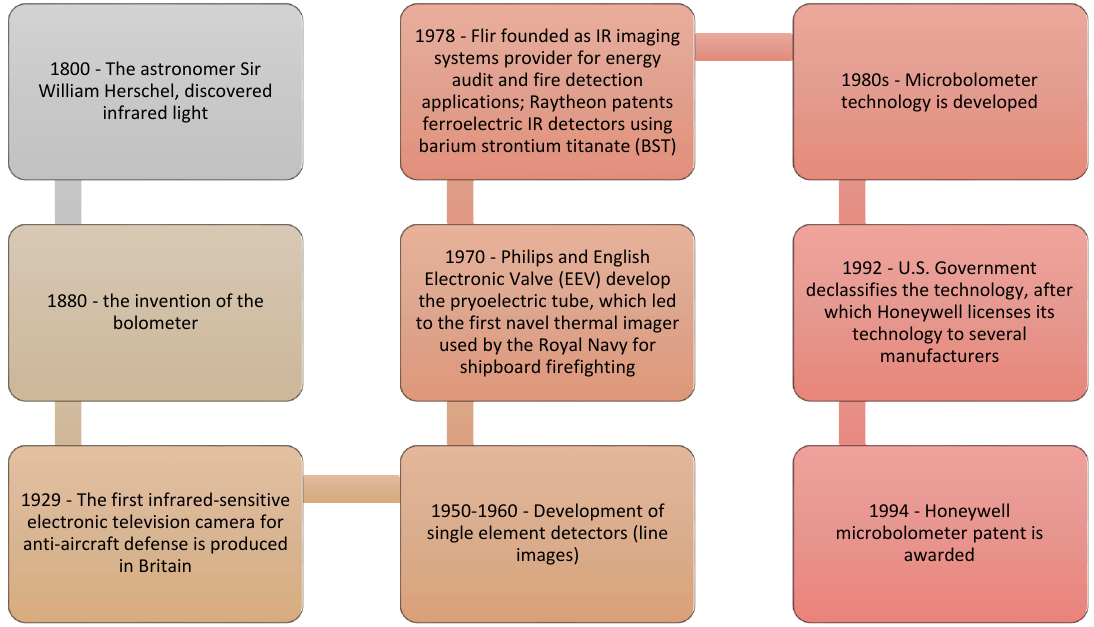
Figure 1. Timeline of infrared (IR) technology [7].